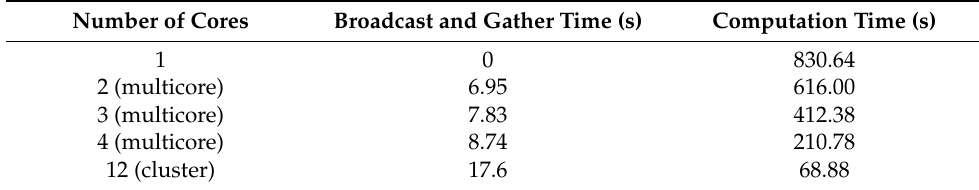
Table 2. Broadcast and gather and computation times for the first parallel section.